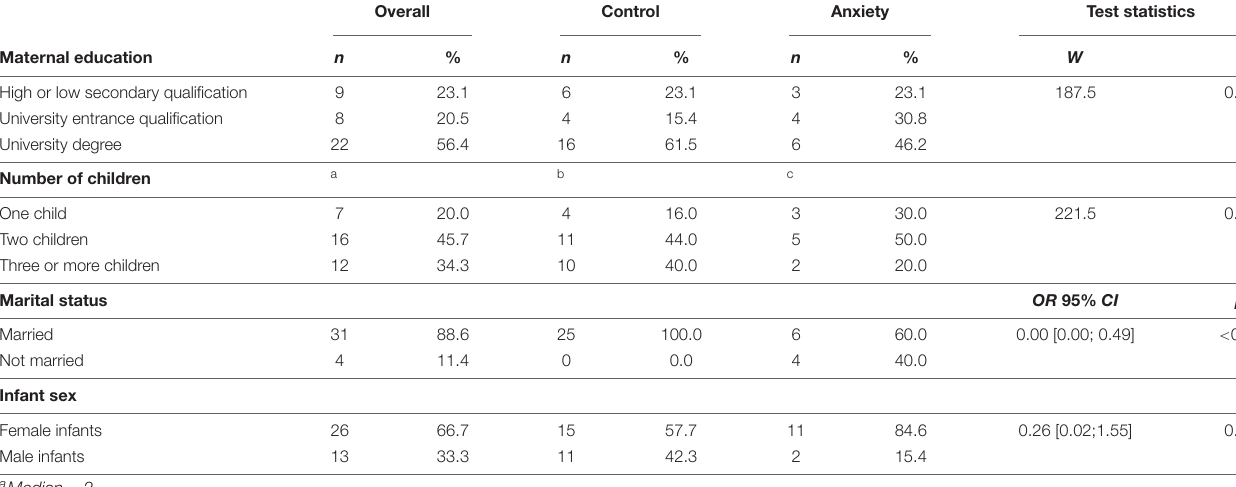
TABLE 3B | Maternal and infant non-parametric demographics and tests on comparability of subgroups 5–6 years postpartum (Study 2). Overall Control Anxiety Test